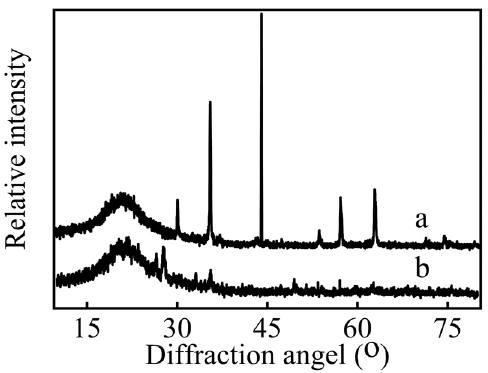
Figure 4: XRD spectra of ceramsite - supported nZVI ( a ) and ceram - site ( b ) .